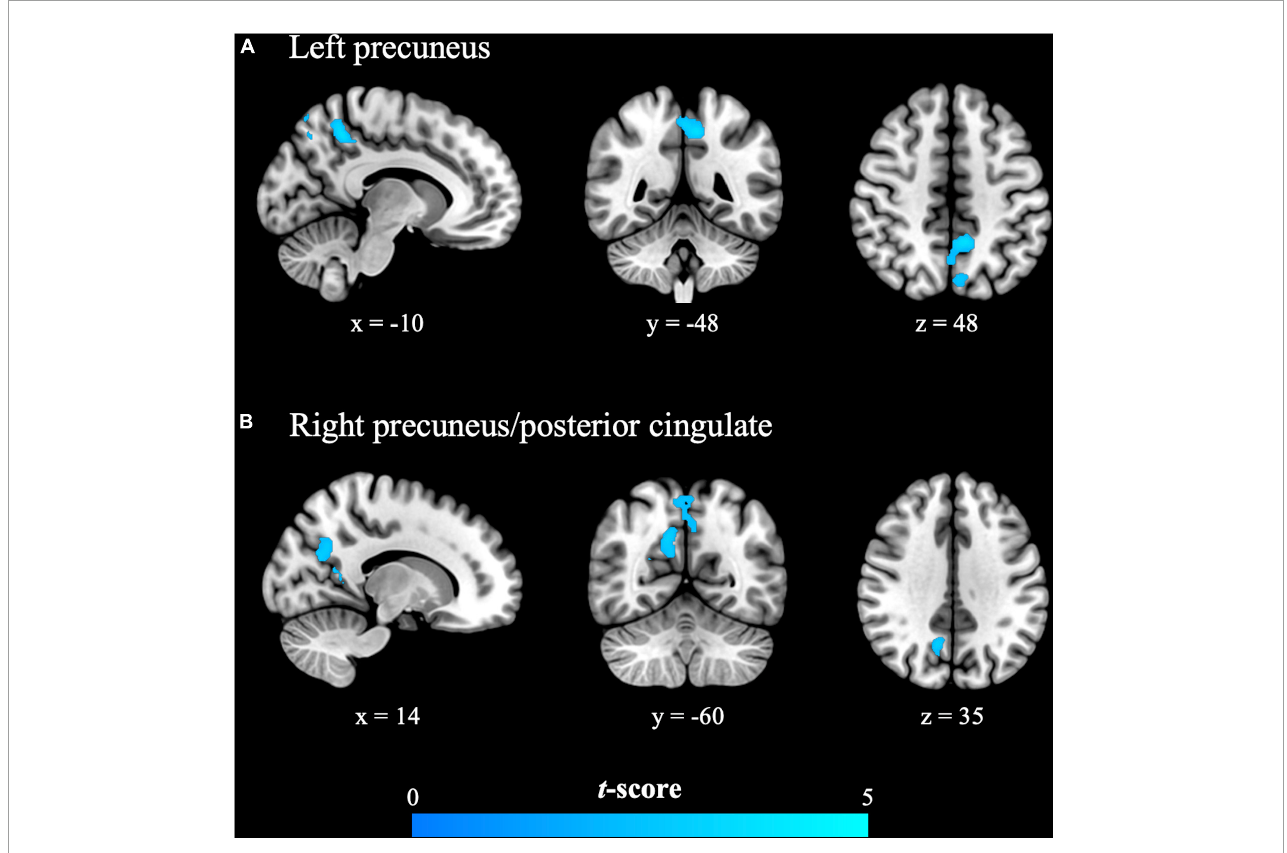
FIGURE1 The primary dysmenorrhea group presented significantly reduced evoked brain responses to cutaneous heat pain in the (A) left precuneus and (B) right precuneus/posterior cingulate during the painful menstrual phase. Significance was set at the uncorrected voxel level of P < 0.005, followed by the family-wise error rate-corrected cluster level of P < 0.05. The cold color (blue) indicates the observed reduction in the evoked brain responses in females with primary dysmenorrhea.